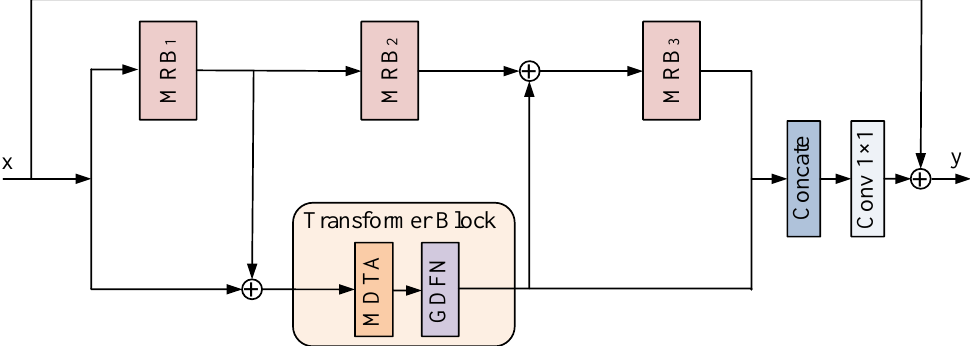
Figure 2. The structure of the proposed Local Global Feature Combination Block.